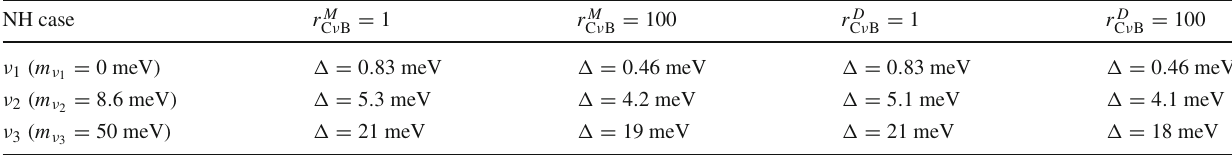
Table 4 The required (cid:9) to distinguish the C ν B signal and the β -decay background for the various ν i with the mass m ν Majorana cases in the normal mass ordering. Here we neglect the neu-